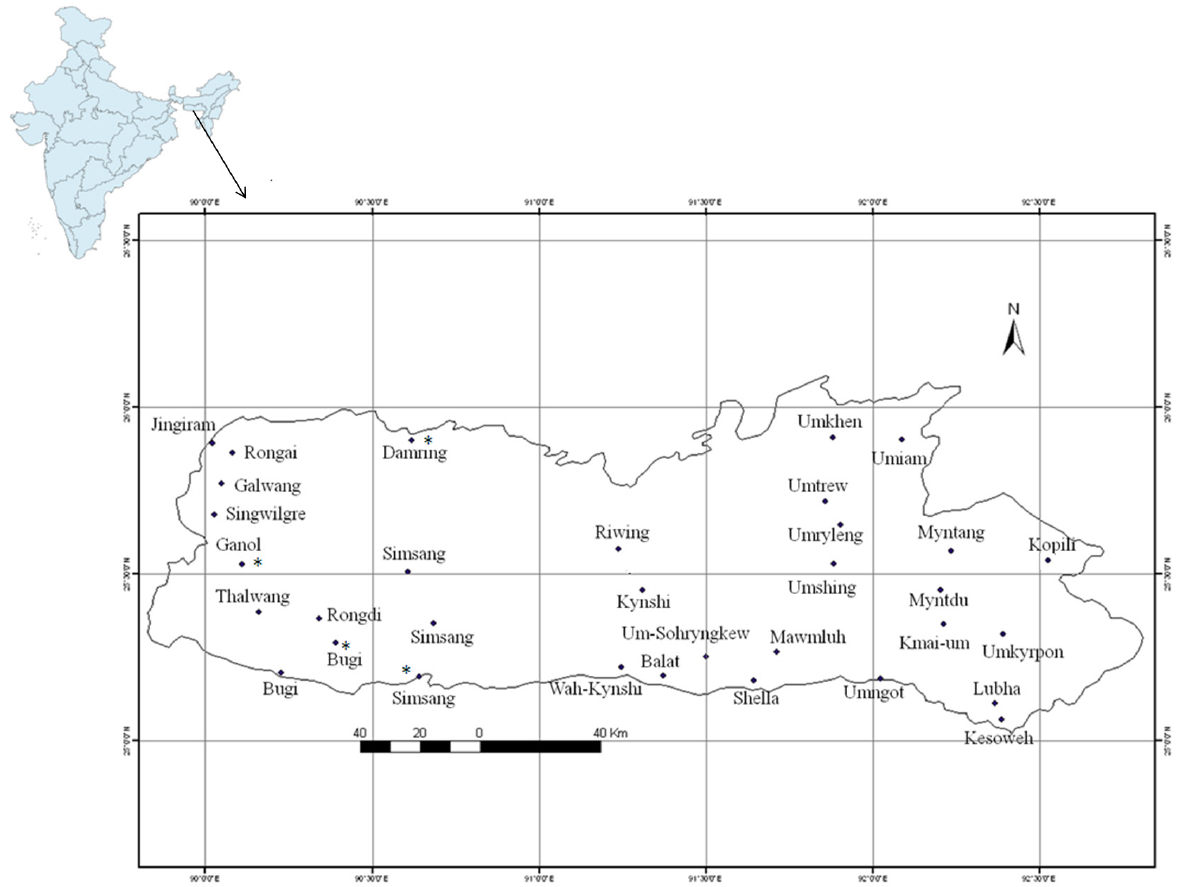
Figure 1. Showing the 33 collection sites in Meghalaya. ( * Shows the collection site of the three new